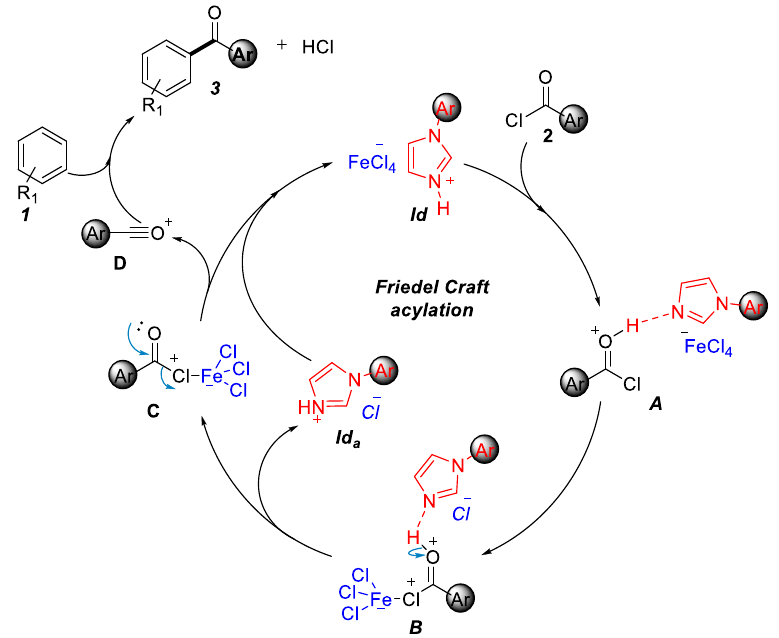
Figure 3. Proposed mechanism of Friedel–Crafts acylation.